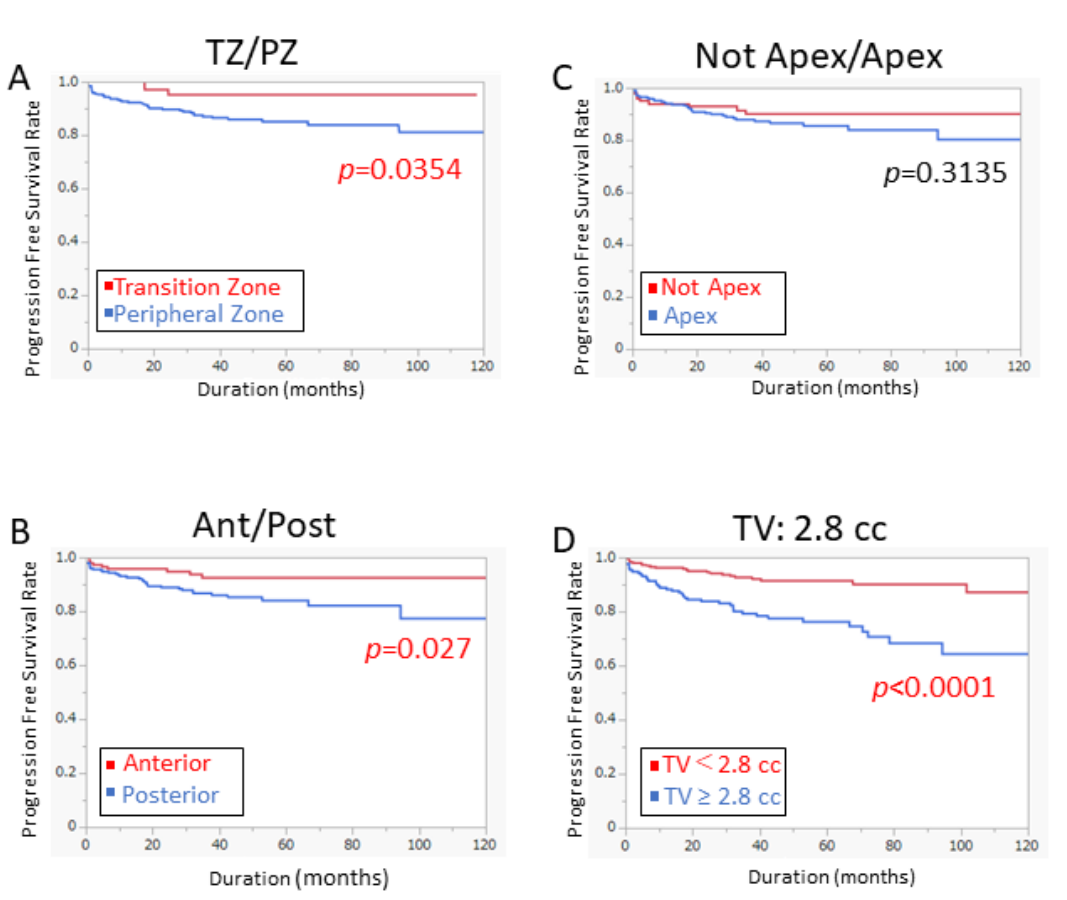
Figure 2. Prognostic significance of tumor location and tumor volume. ( A ) Patients with tumor in the PZ had significantly worse PFS than those in the TZ ( p = 0.0354). ( B ) Patients with tumor in the posterior region had significantly worse PFS than those in the anterior region ( p = 0.027). ( C ) There was no difference in PFS between apex and non-apex regions. ( D ) Patients with tumor volume ≥ 2.8 cc had significantly worse PFS than those <2.8 cc ( p < 0.0001). Table 3. Univariable and multivariable cox proportional hazard regression models in predictive factors for PFS in localized Pca (overall risk) with unfavorable